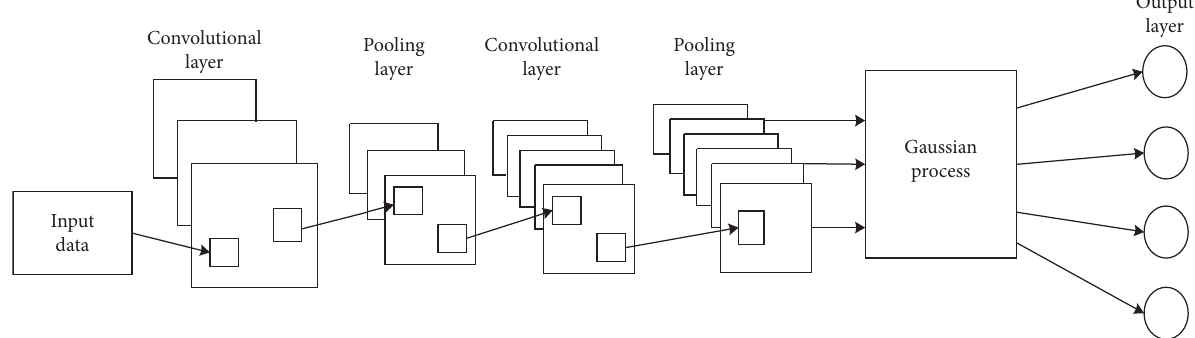
Figure 2: Deep Gaussian process network